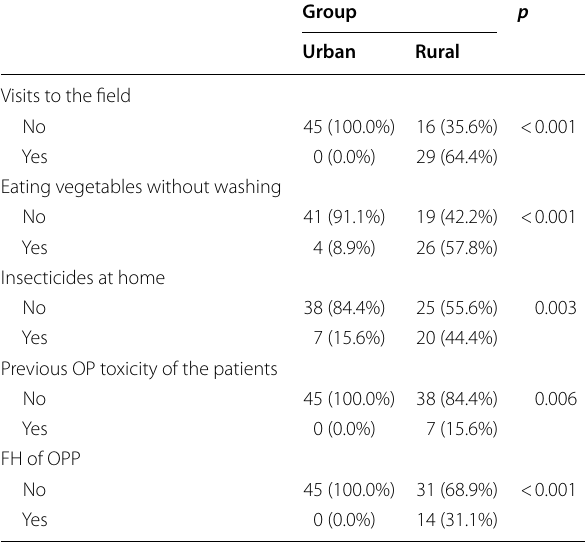
Table 2 Comparison between urban and rural children